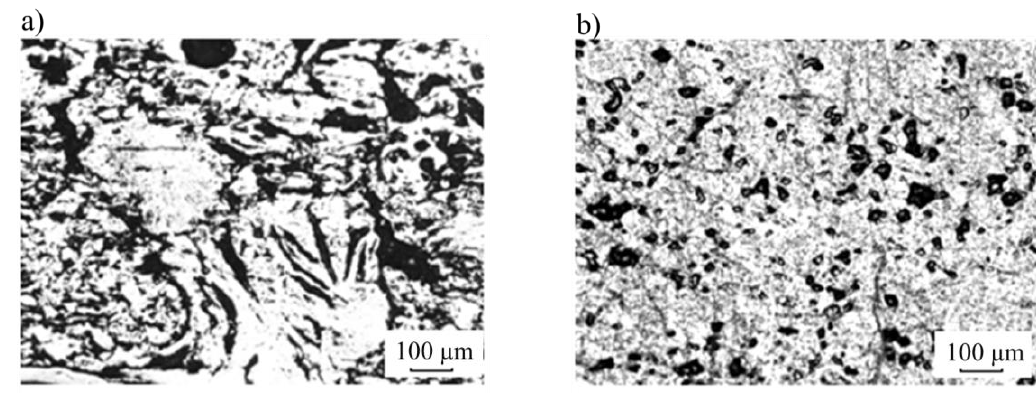
Figure 6. Optical microscopy images of the ( a ) carbon and ( b ) graphite anodes.